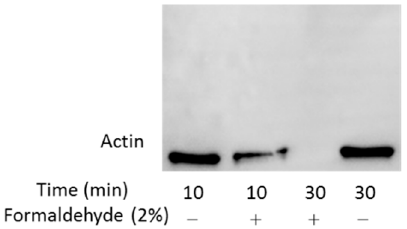
Figure 8. Western blot analysis of β -Actin from the formaldehyde-treated samples. After formaldehyde-induced artificial cross-linking of proteins, actin could not be detected by antibodies any more.